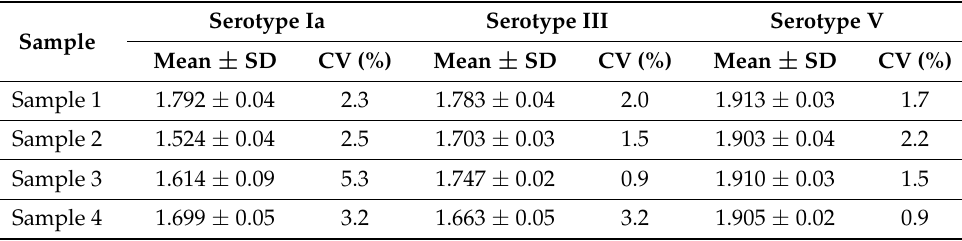
Table 3. Inter-assay precision of group B Streptococcus enzyme-linked immunosorbent assay (GBS- ELISA) for serotype-specific